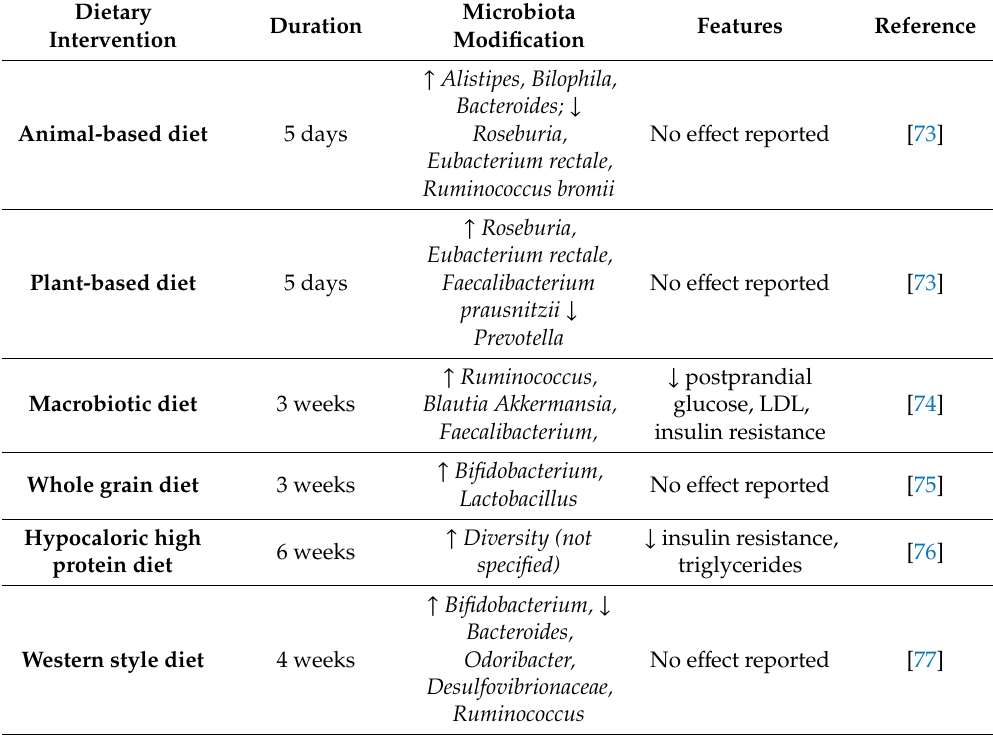
Table 2. Overview of some dietary intervention and microbiota modification. Animal-based diet: composed of meats, eggs, and cheeses; plant-based diet: rich in grains, legumes, fruits, and